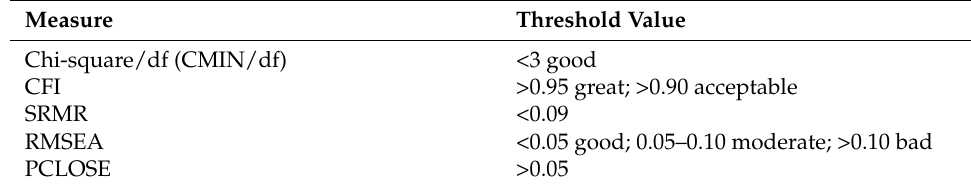
Table 5. Cut-off point for model